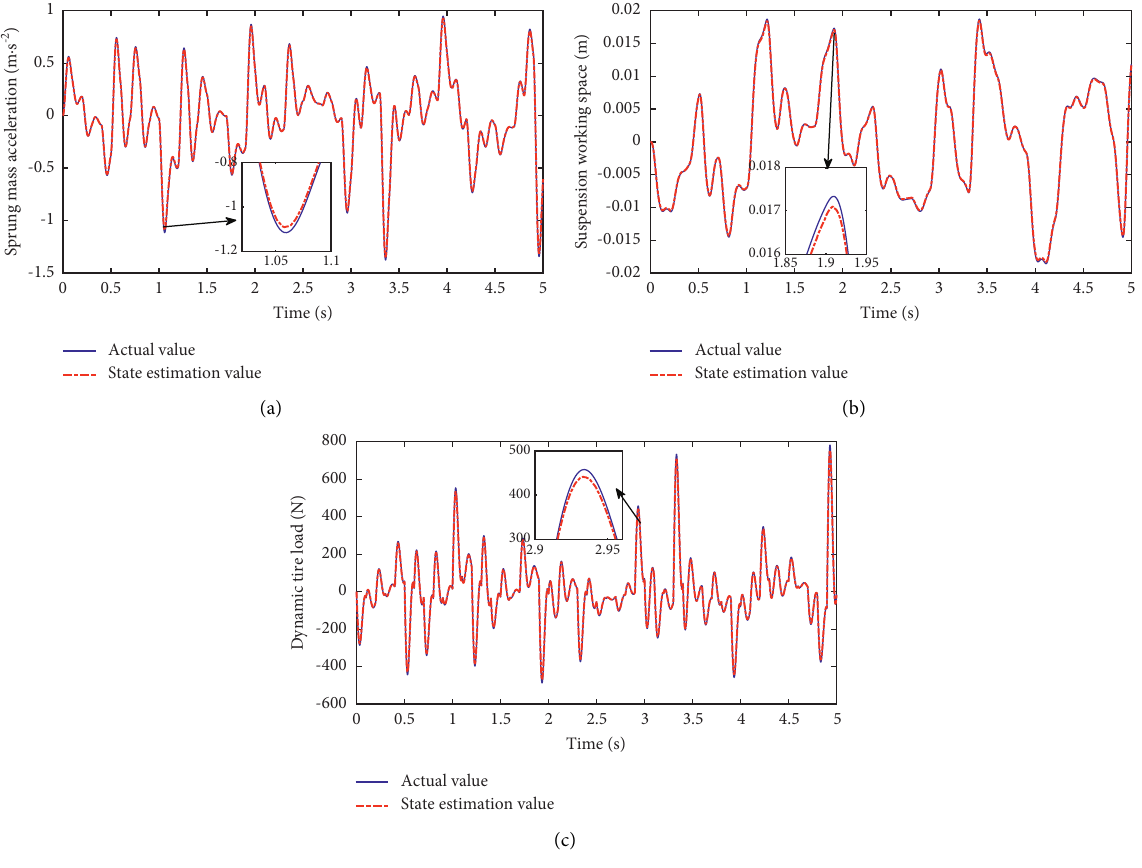
Figure 13: Comparison chart of state estimation value and actual value. (a) Comparison of sprung mass acceleration. (b) Comparison of suspension working space. (c) Comparison of dynamic tire load.